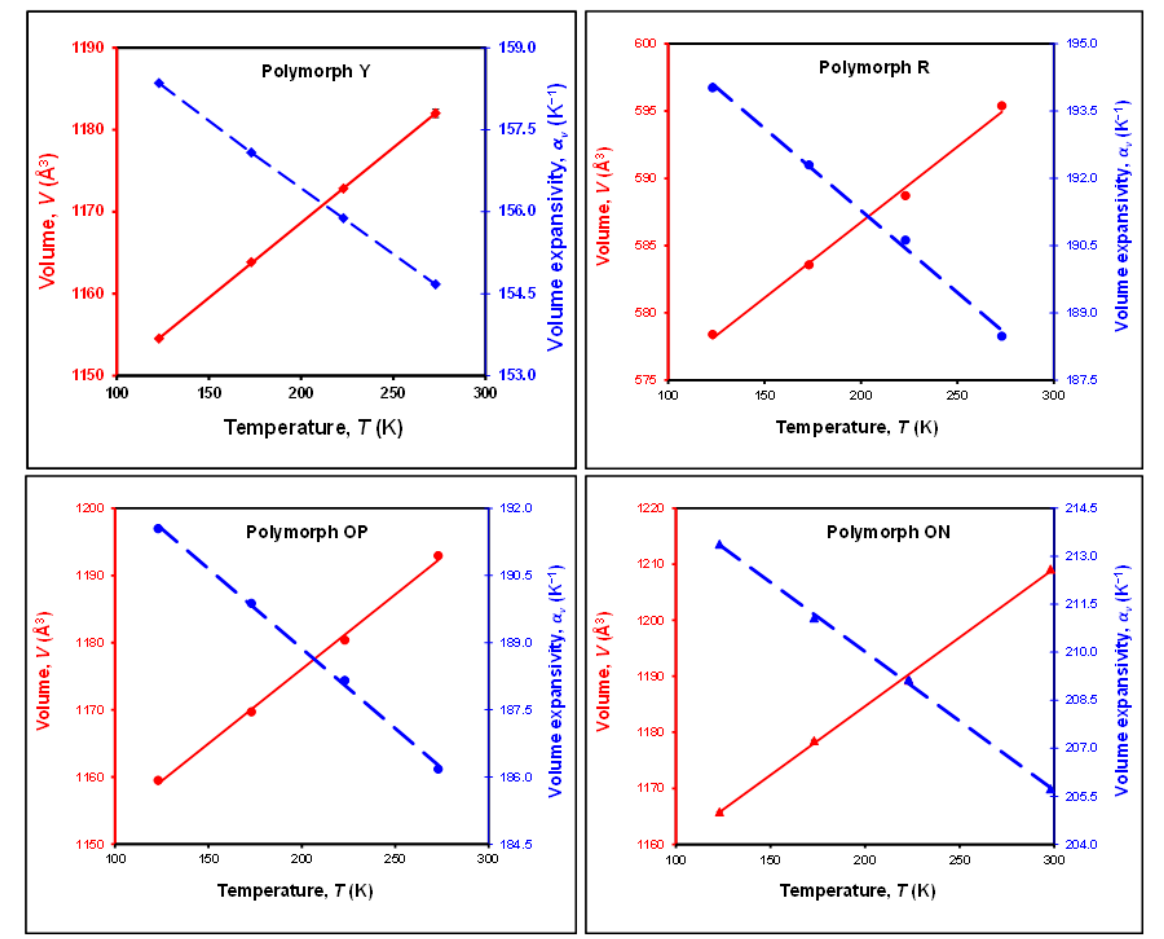
Figure 2. Variations of unit cell volume ( V ; solid line) and volume expansivity ( α v ; dotted line) with temperature for Y, R, OP, and ON polymorphs. At all temperatures, α v is the smallest for polymorph Y, and the largest for polymorph ON.